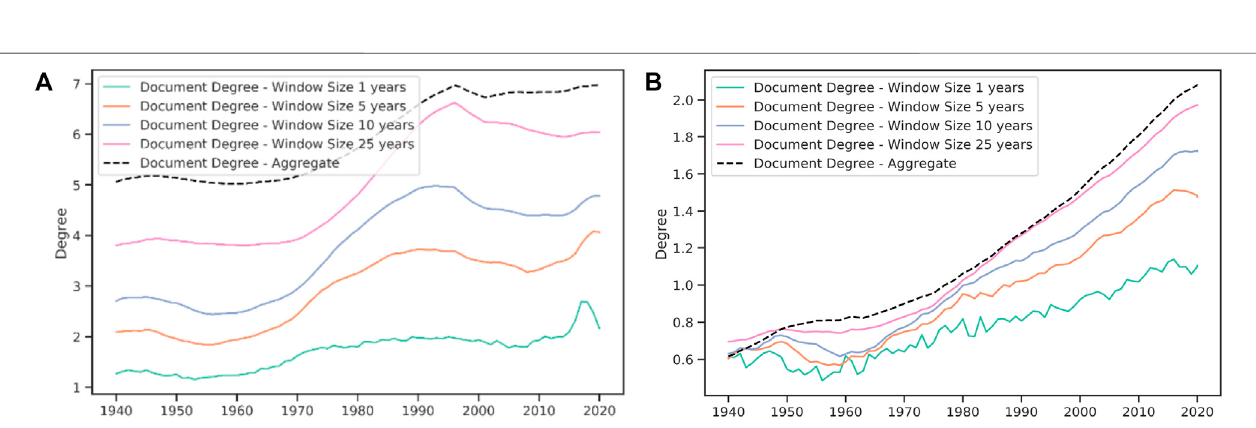
FIGURE 6 | Distribution of case average degree. (A) The complete network (B) The cross-jurisdiction network. Window widths. τ (cid:1) { 1 , 5 , 10 , 25 } .